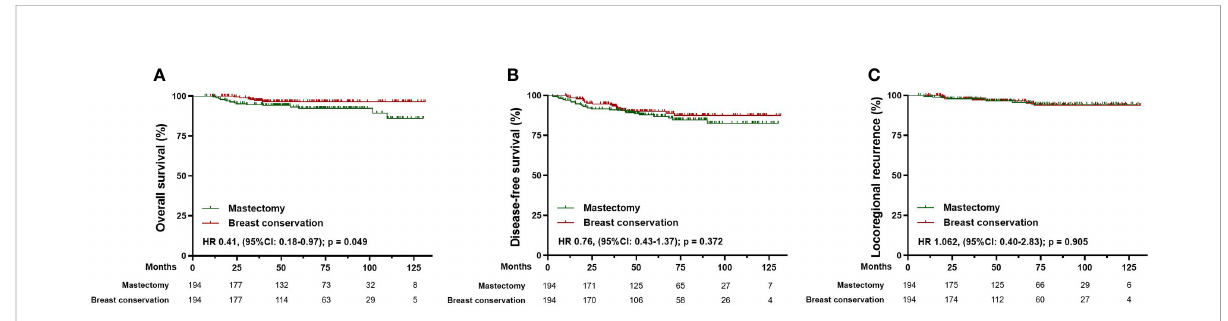
FIGURE 4 Survival analysis in the matched cohort of patients receiving mastectomy (n=194) and breast conservation (n=194). (A) Kaplan-Meier curves for overall survival analysis in patients of different surgical groups. (B) Kaplan-Meier curves for disease-free survival analysis in patients of different surgical groups. (C) Kaplan-Meier curves for locoregional recurrence analysis in patients of different surgical groups. HR, Hazard ratio; 95% CI, 95% con fi dence